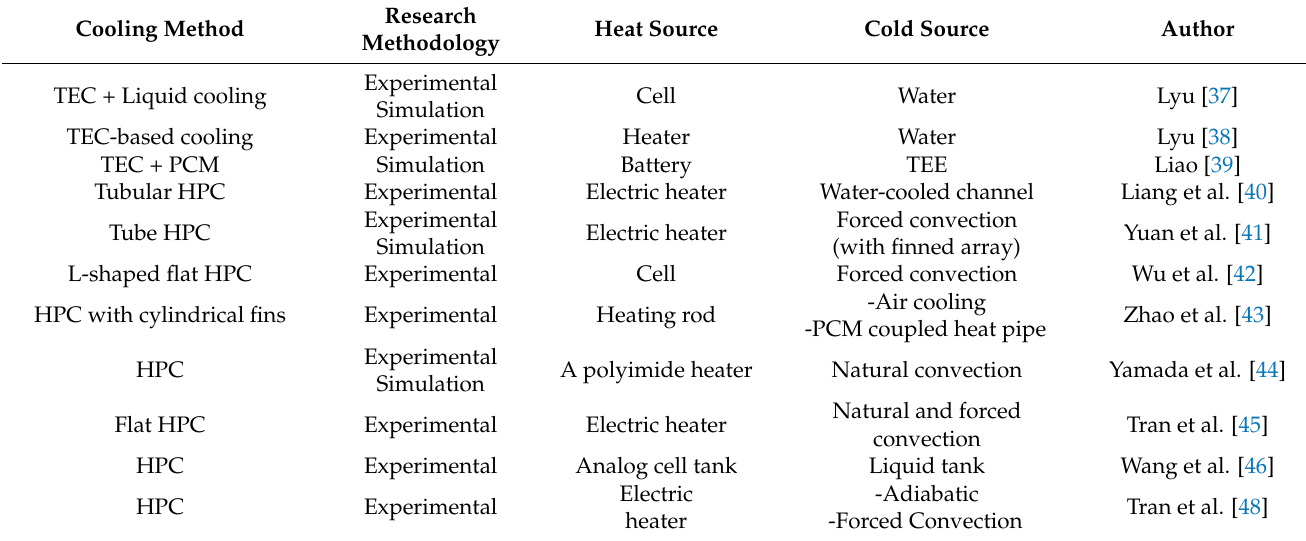
Table 1. Summary of other cell thermal management studies [47].